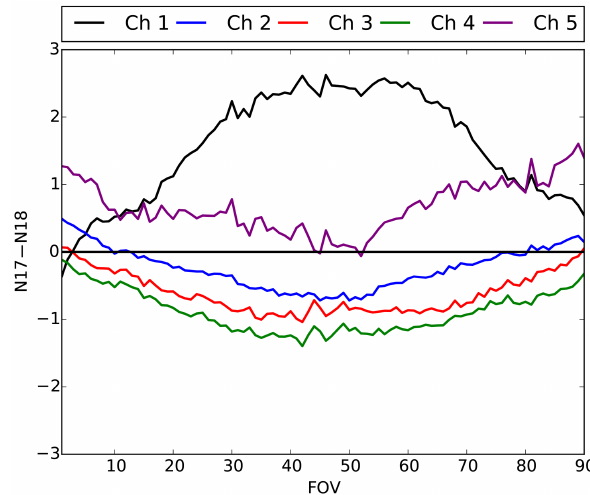
Figure 3. Effect of polarization on the difference between NOAA- 17 AMSU-B and NOAA-18 MHS observations averaged over trop- ical ocean for different